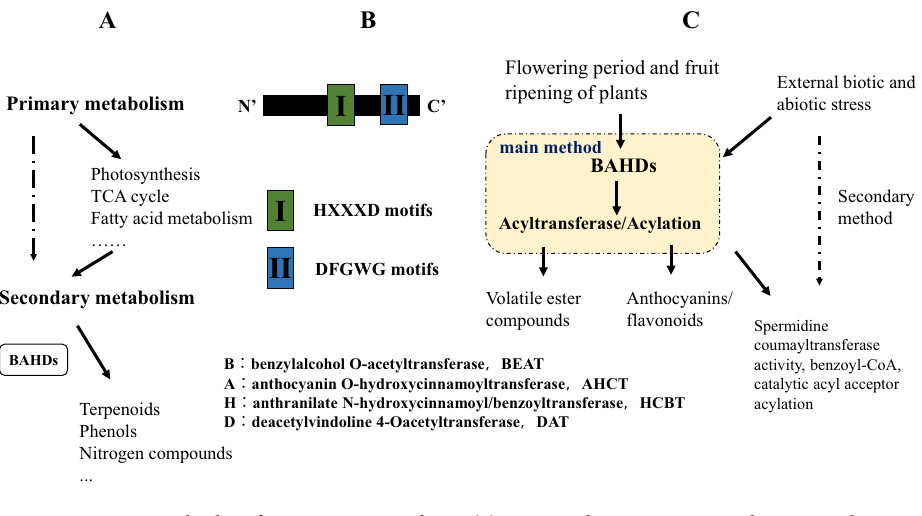
Figure 1. Functional roles of BAHD genes in plants. ( a ) BAHDs play a prominent role in secondary metabolism. ( b ) Typical protein structure of BAHDs. ( c ) Activation of